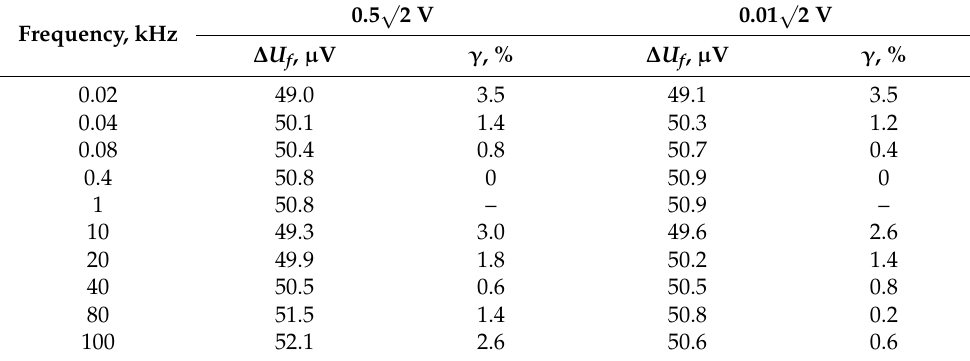
Table 5. Frequency range of lock-in amplifier.